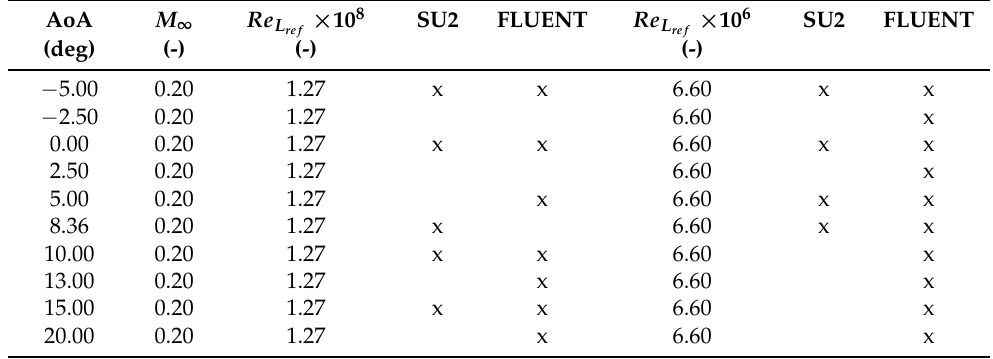
= 1.27 × 10 8 ) and WT test ( Re L ref